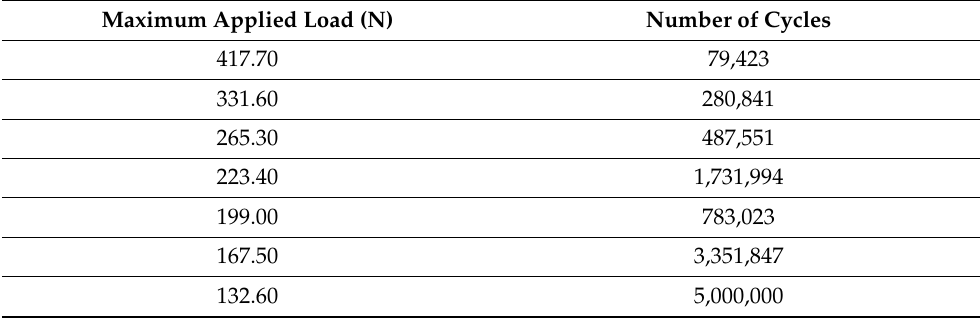
Table 2. The number of cycles supported by our dental implants for each